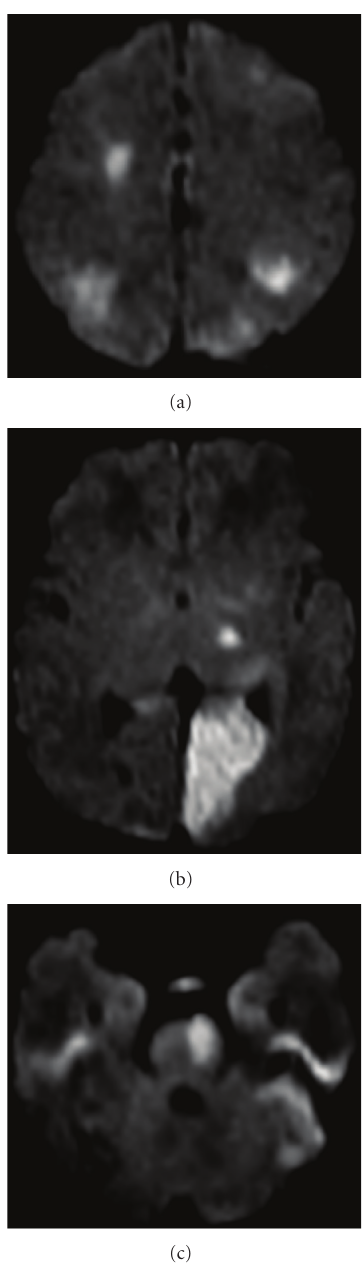
Figure 1: (a)–(c): Axial di ff usion-weighted images, b = 1000, demonstrate multiple areas of high signal in bilateral frontal and parietal lobes, left occipital lobe, left thalamus, and left